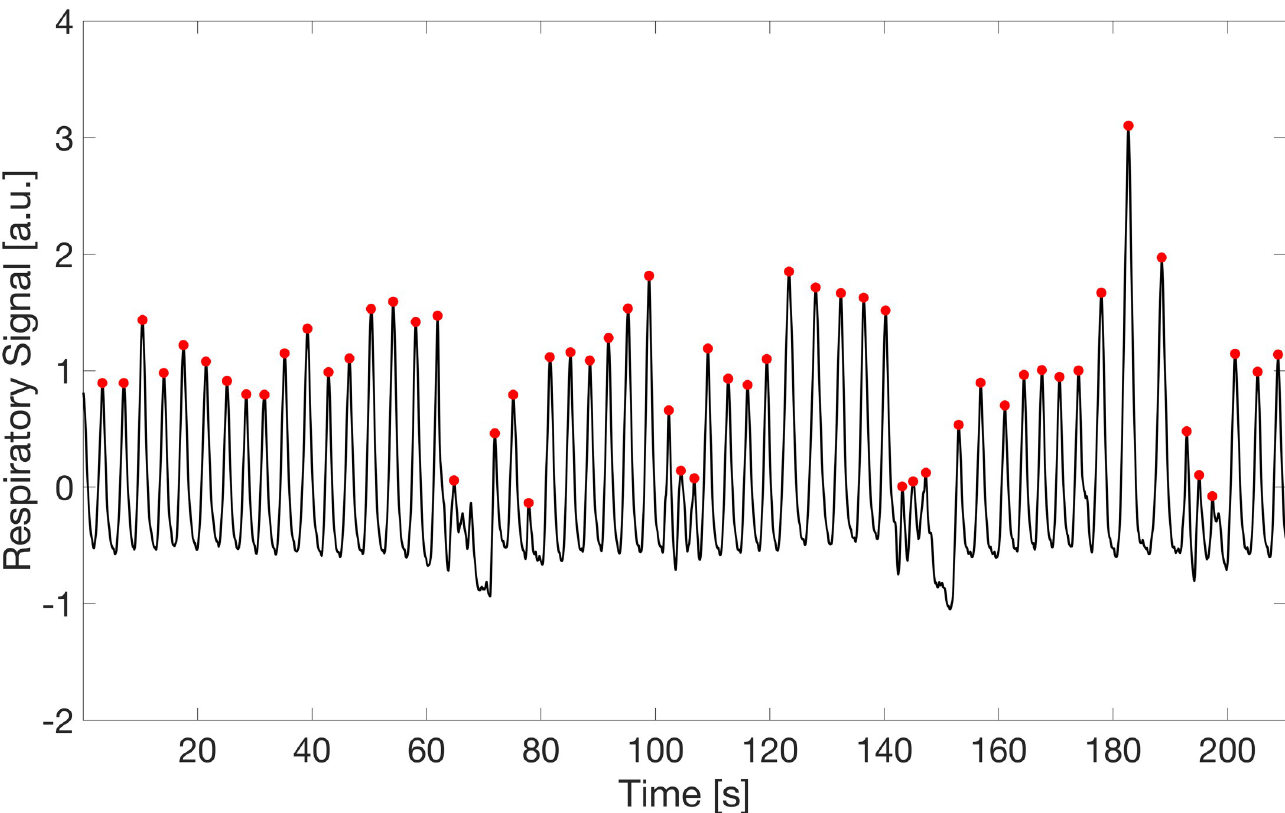
Fig 3. Respiratory signal. The respiratory signal of a participant is depicted. The peaks are marked by red dots. Around the 70th and 150th seconds two deflections are visible, corresponding to the moments in which the participant was